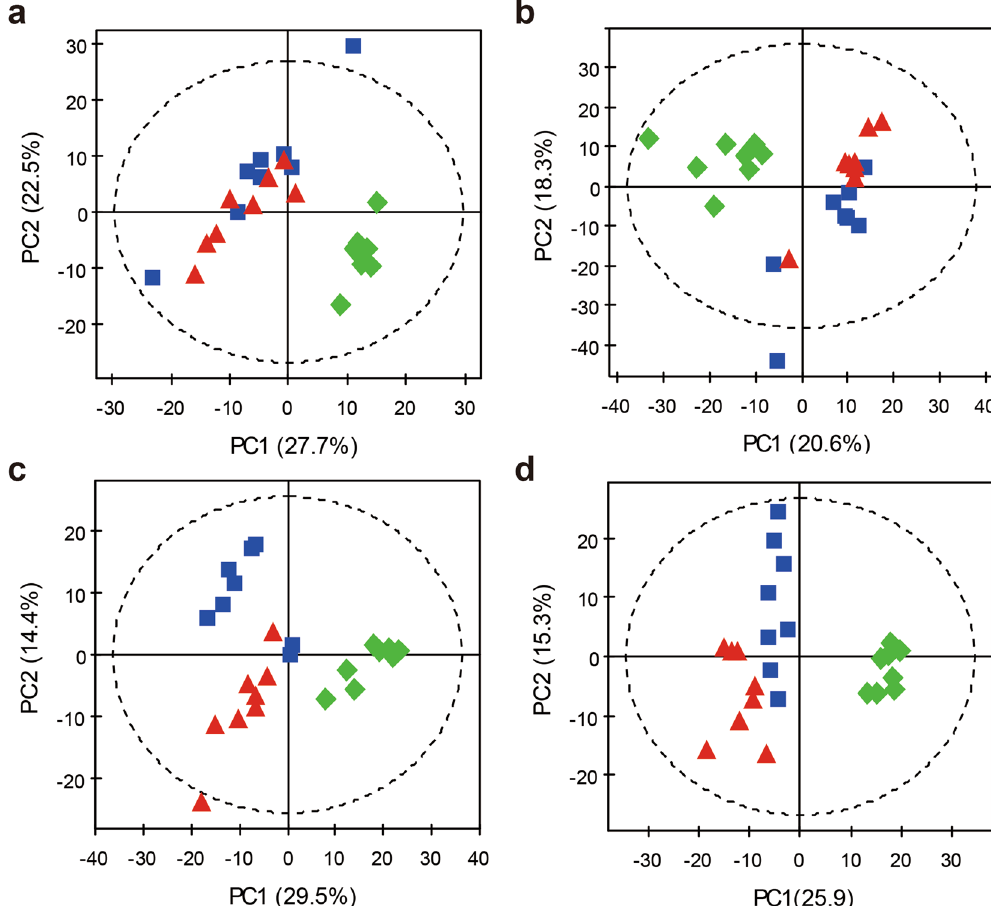
Figure 3. PCA scores plots of the control ( ), SMFY ( ) and GMFS ( ) groups for ( a ) serum, ( b ) urine, ( c ) stomach extract, and ( d ) cortex